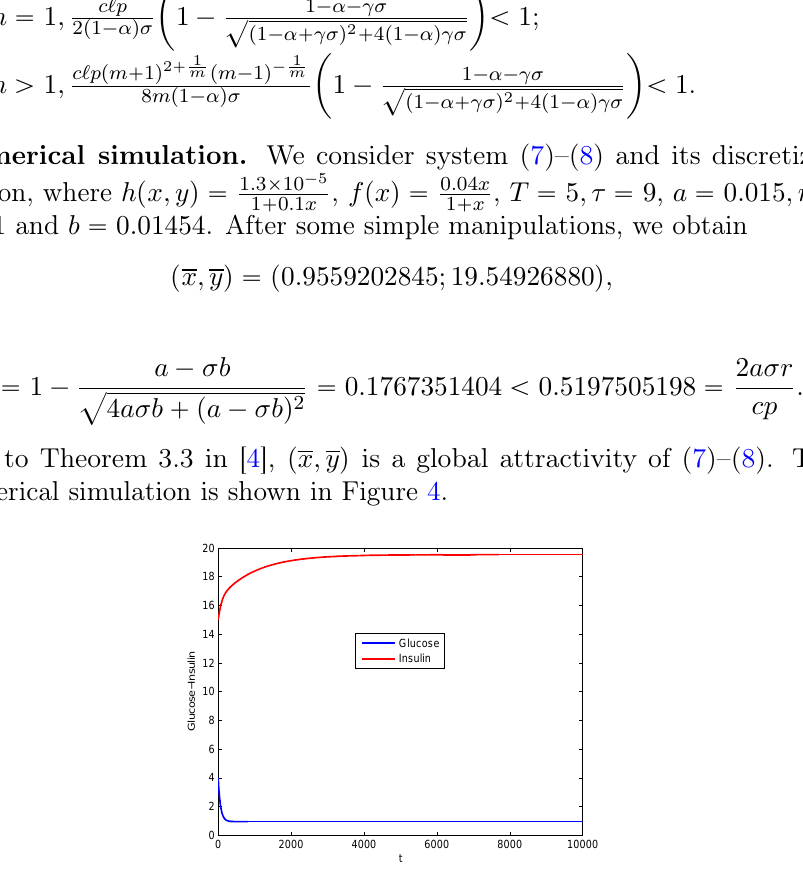
Fig. 4. Plot of the continuous model with p x, y q “ p 0 . 9559202845; 19 . 54926880